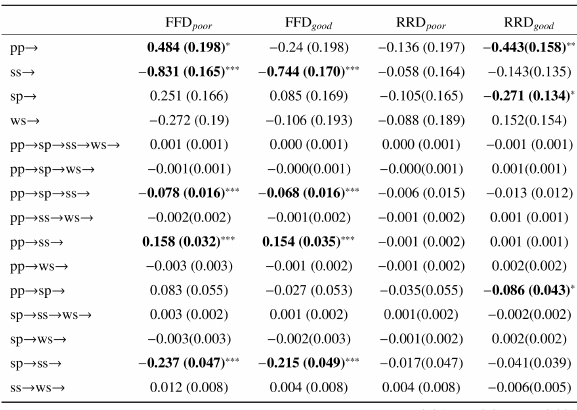
Table 6 Estimates (and their standard errors) for the path